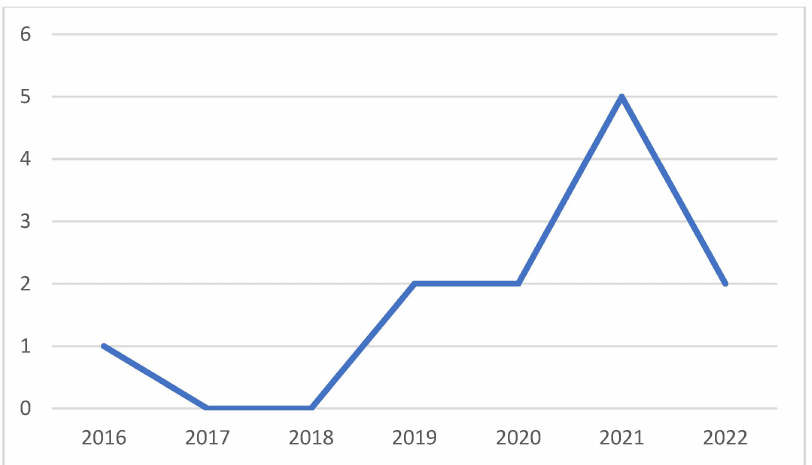
Figure 3. Number of papers per year.